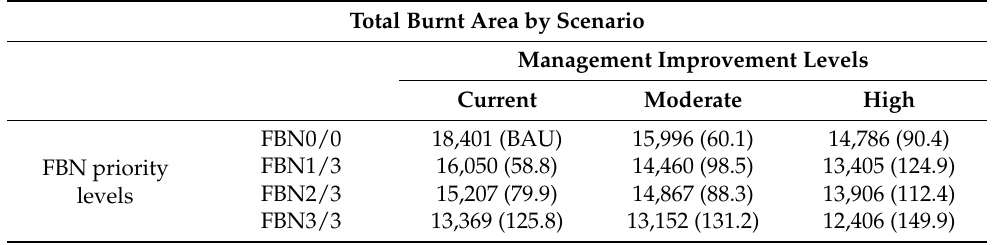
Figure 3. Observed overestimated distribution of the time between consecutive wildfires; NB—the dots represent fire frequencies for pixels that never burned. Table 3. Total simulated burned area for the 40-year period, and annual average decrease in estimated burned area (ha), when compared with the BAU scenario (inside